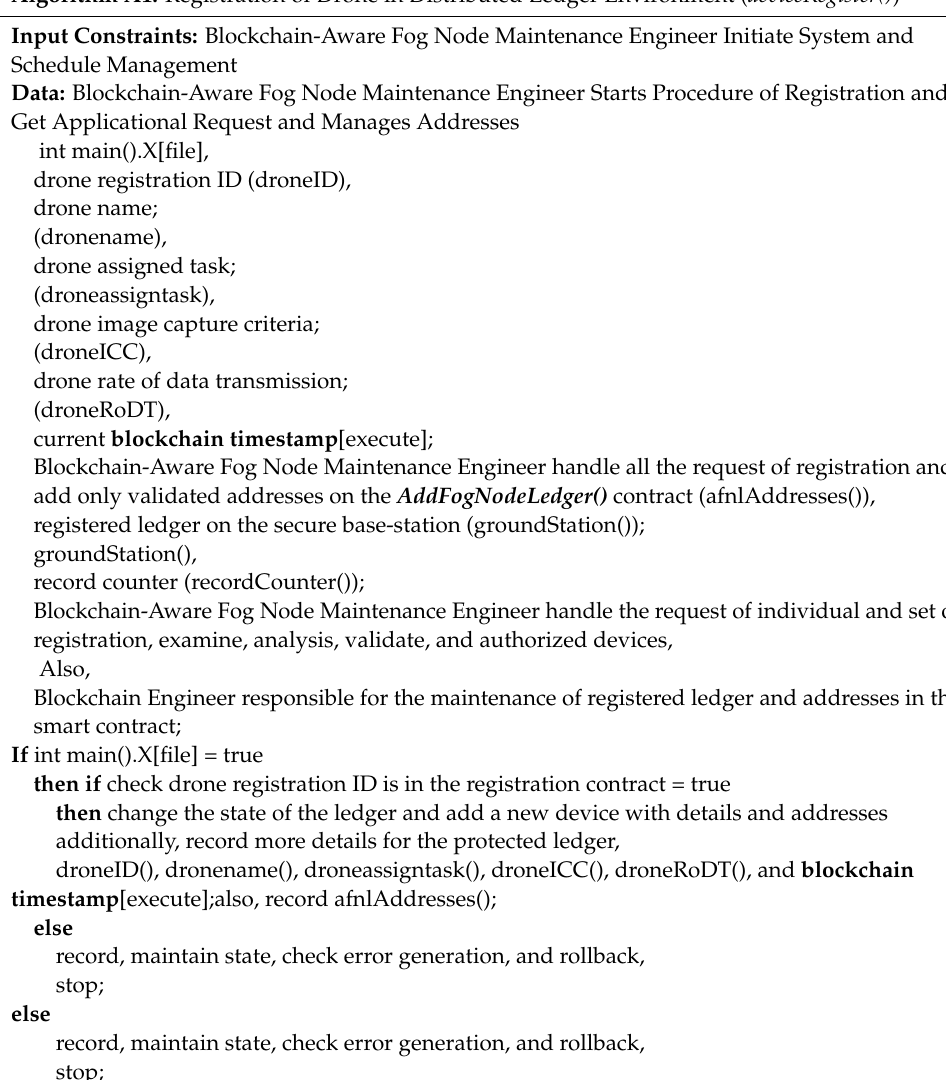
Algorithm A1. Registration of Drone in Distributed Ledger Environment ( deviceRegister()